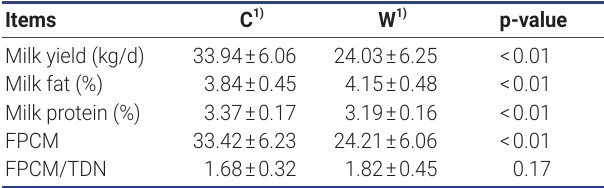
Table 4. Comparison of ruminal pH value between conventional farm and welfare farm for 3 days Item